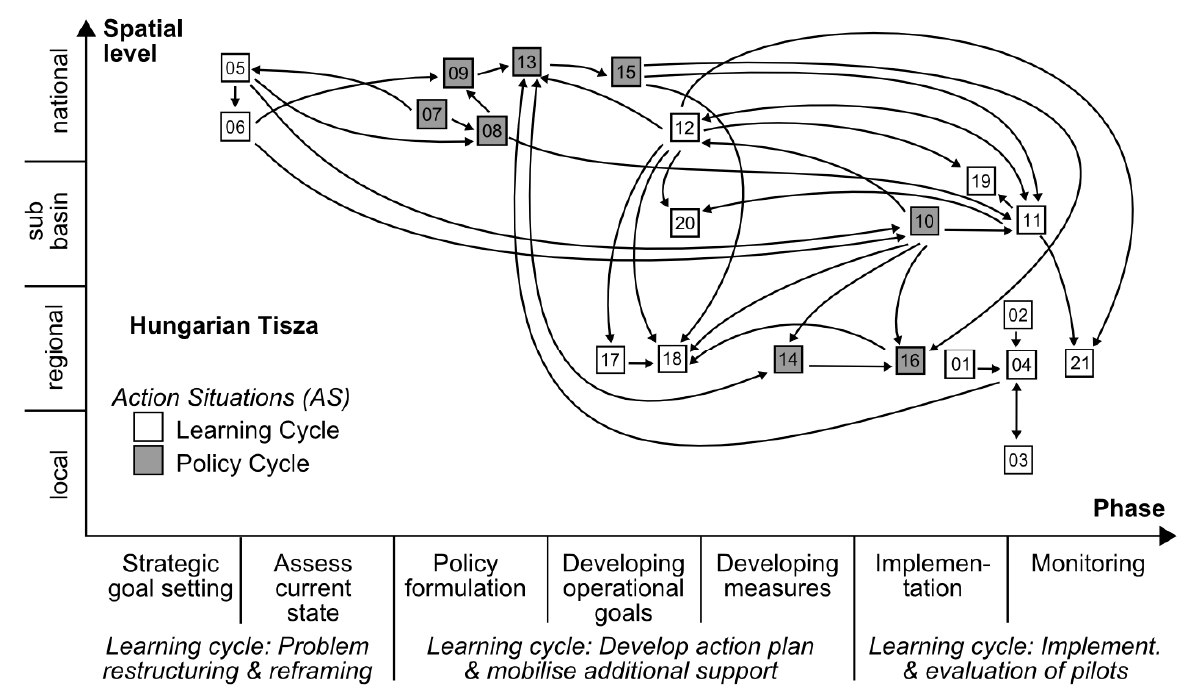
Figure A1. Formal policy and informal learning processes and their interdependencies in the Hungarian Tisza. Non-aggregated version of Fig. 3. The numbers refer to the ASs as listed in Table